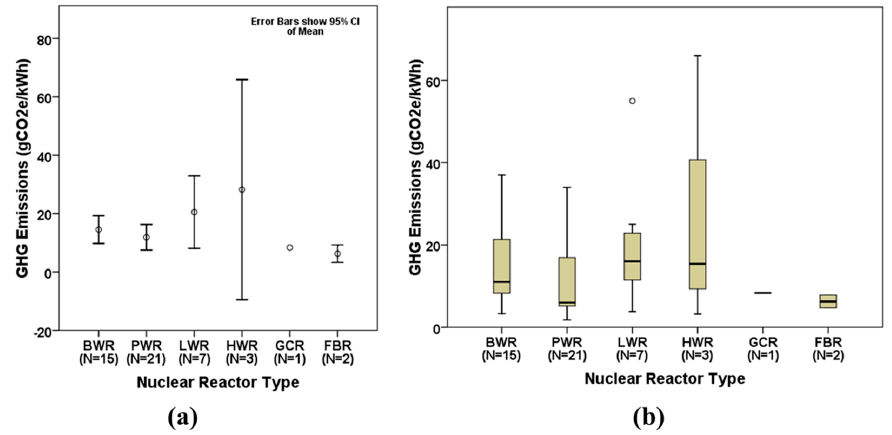
Figure 1. GHG emissions from different nuclear power generation systems: ( a ) mean ± 95% CI error bars; and ( b ) quartile box plots. Table 2. GHG emission (gCO 2 e/kWh) statistics from different nuclear power generation systems.